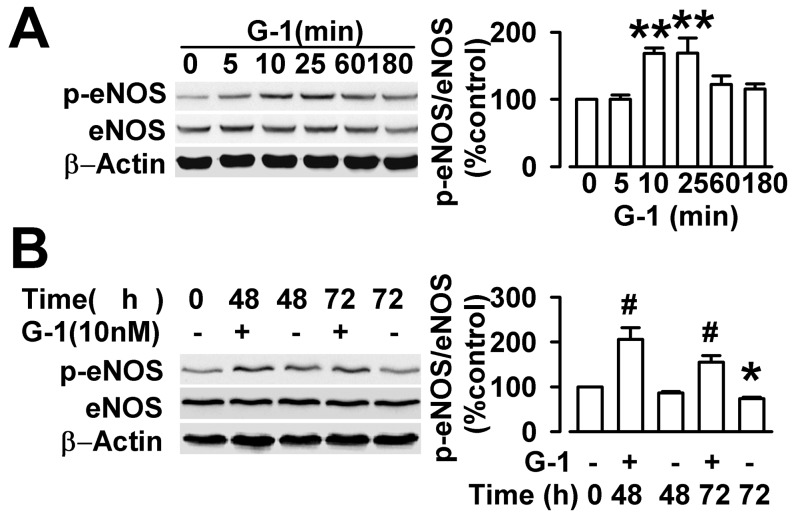
Effect of G1 on eNOS enzymatic activity in endothelial cells.(A) The endothelial cells were cultured in vitro, and treated with G1 (10 nM) for 5, 10, 25, 60, 180 min. G1 activated eNOS phosphorylation after 5–10 min treatment. The increased level was maintained up to 30 min, followed by a reduction at 1 h. **
p<0.01 compared with control. (B) Endothelial cells were exposed to high glucose concentration (33 mM) for 48 or 72 h, and then incubated with G1(10 nM) for 10 min. G1 treatment (10 nM, 10 min) reversed the down-regulation of phosphorylation level of eNOS by high concentration of glucose. *
p<0.05 compared with the glucose treated before; #
p<0.05 compared with the glucose treated at 48 h or 72 h without G1. Results are given as the mean ± SEM of three independent experiments.